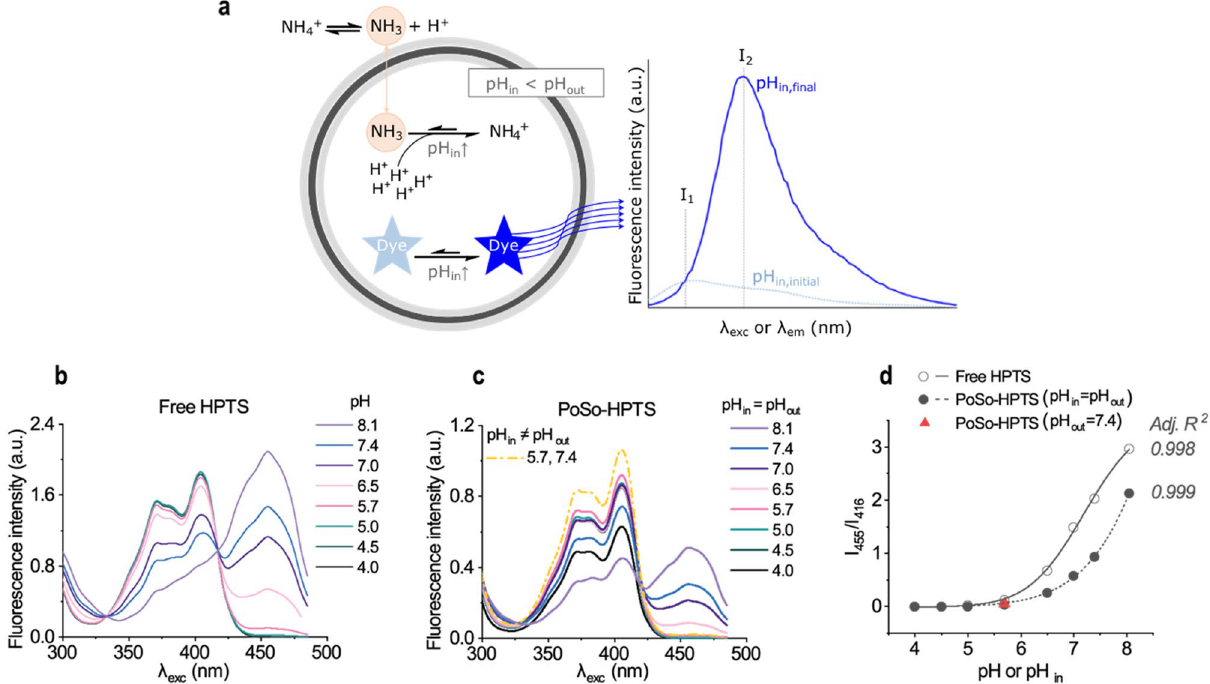
Figure 1. Working principle of PoSo-based ammonia assay, and fluorescence properties of free HPTS vs. PoSo-HPTS. ( a ) Once the ammonia-containing sample is mixed with the PoSo suspension, uncharged ammonia molecules diffuse into the vesicle’s acidic core, where they ionize to ammonium and then become trapped in the PoSo. The pH in hence increases and the fluorescence signal of the encapsulated pH-sensitive, ratiometric dye changes. ( b – c ) Fluorescence excitation spectra (for λ em 515 nm) of free HPTS ( b ) and PoSo-HPTS ( c ) with pH in = pH out (solid lines) and one sample with pH in ≠ pH out (dash-dotted line) for comparison. ( d ) Fluorescence intensity ratio I 455 /I 416 at λ em 515 nm (i.e. for λ exc 455 and 416 nm) for free HPTS and PoSo-HPTS (symbols) against pH or pH in , respectively. Lines correspond to four-parameter logistic